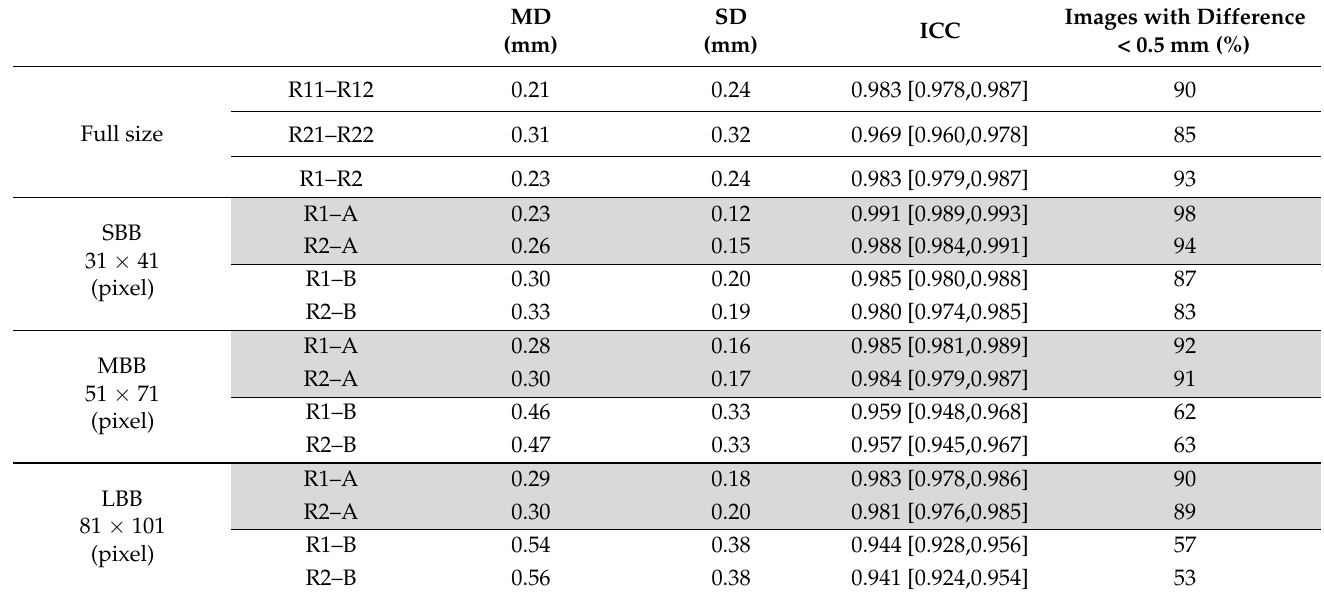
Table 1. Comparison of CEJ identification between the proposed method and the two raters for different bounding box sizes (SBB, MBB, LBB) with image preprocessing scenarios (A) and without (B). The full size refers to the whole image size (e.g., 360 × 386 pixels). SBB, MBB, and LBB denote the small (31 × 41 pixels), medium (51 × 71 pixels), and large (81 × 101 pixels) bounding boxes,